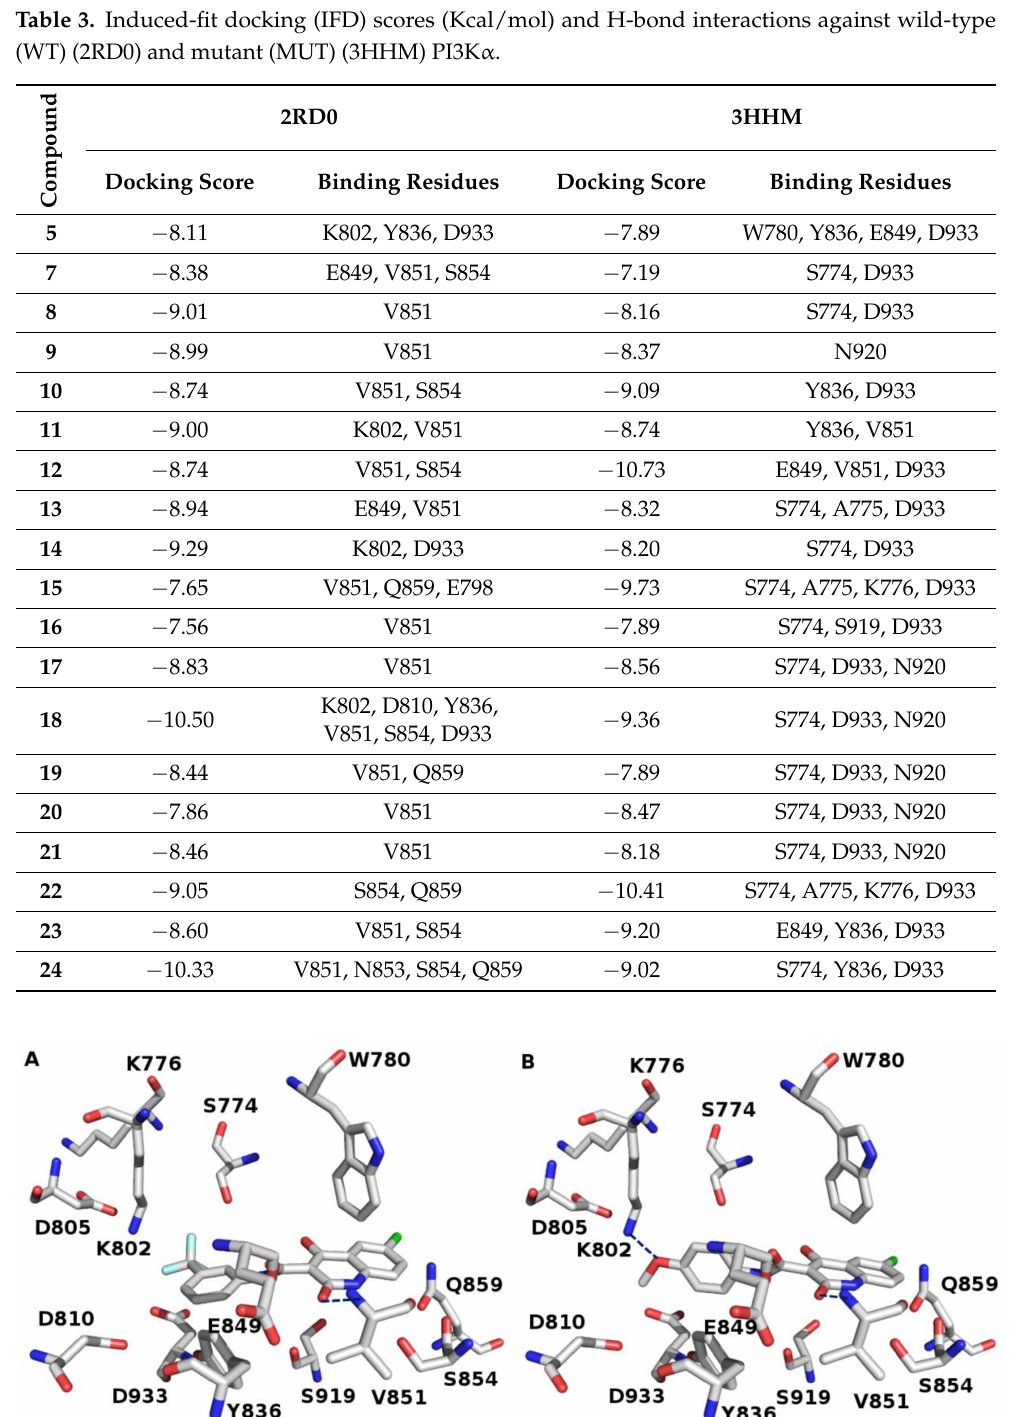
Figure 5. Binding poses of ( A ) 9 and ( B ) 11 in the 2RD0 kinase site. The H-Bond is represented as a blue dotted line. H atoms are hidden for clarification. Picture made by PYMOL